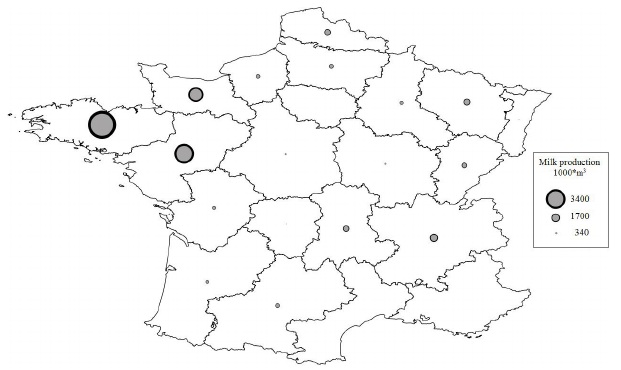
Fig. 2. Milk production per French administrative region. Data sources: Statistique agricole annuelle,